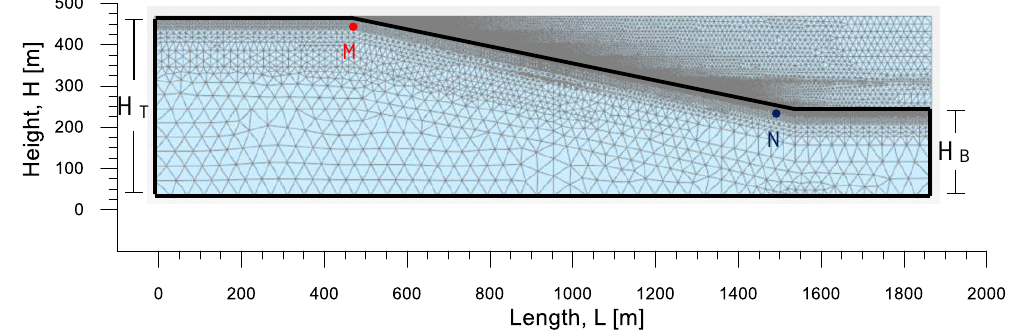
Figure 4. Mesh of the numerical model, together with the final geometry of the slope after the initialization stage (bold contour). Both the red and the blue points (M, N) are 5 m below ground level. Both the left and right vertical boundaries are set to be impervious, since they represent a watershed and the centre of the river valley, respectively, according to the in situ conditions. Consistently, at both these boundaries, the horizontal displacements are set to null. The bottom boundary has been set as impervious and of null total displacement. The distance of the bottom boundary from the top of the ground surface in the slope model has been chosen after a sensitivity analysis [54], showing that both the seepage regime and the stress-strain states in the model do not change any more, for depths of the model bottom boundary higher than 200 m below the ground level at the slope